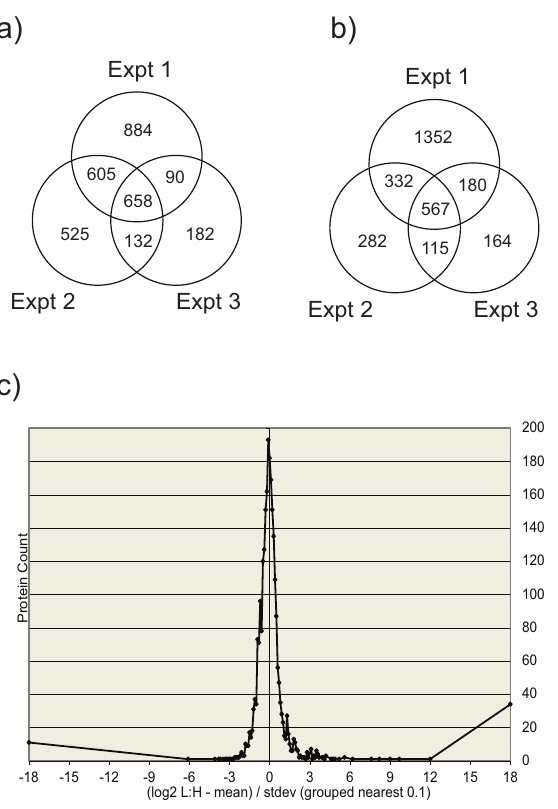
Figure 3. Identified protein analysis. Venn diagram summaries of the three separate T1L reovirus SILAC experiments at (a) 6hpi, when a total of 3076 unique proteins were identified and at (b) 24hpi where a total of 2992 unique proteins were identified. Overlapping numbers represent those proteins identified in more than one biological replicate (c) Population distribution represented by the log 2 of L:H ratios of identified proteins plotted against the protein counts. This population distribution is used to determine the z-scores indicating those proteins considered significantly up or down regulated. Most proteins are seen at a 1:1 ratio after infection, indicated by the peak of the population distribution indicated at 0. For clarity, only experiment 1 at 24hpi is shown, however population distributions were generated at both time points, for all biological replicates.